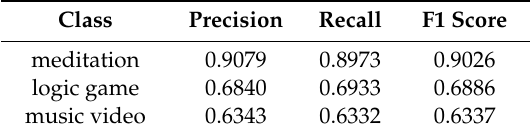
Table 27. Values of precision, recall, and F1 score for each activity class for NN with three hidden layers with the LeakyReLU activation function and the welch32 feature extraction scheme (10-fold